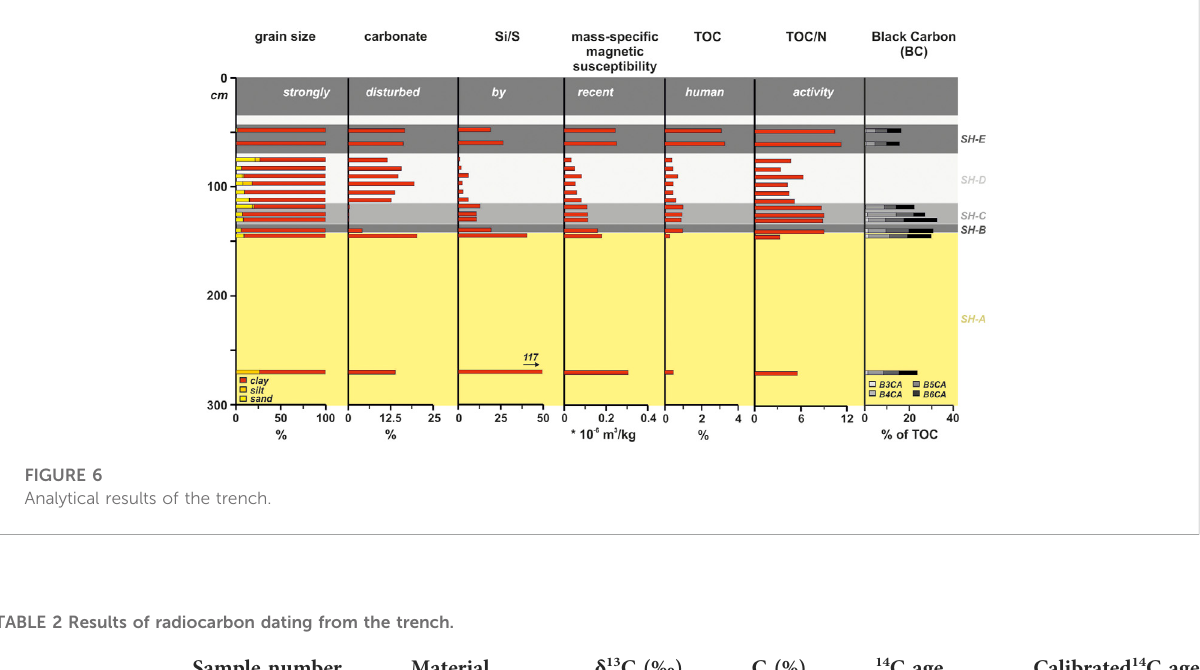
TABLE 2 Results of radiocarbon dating from the